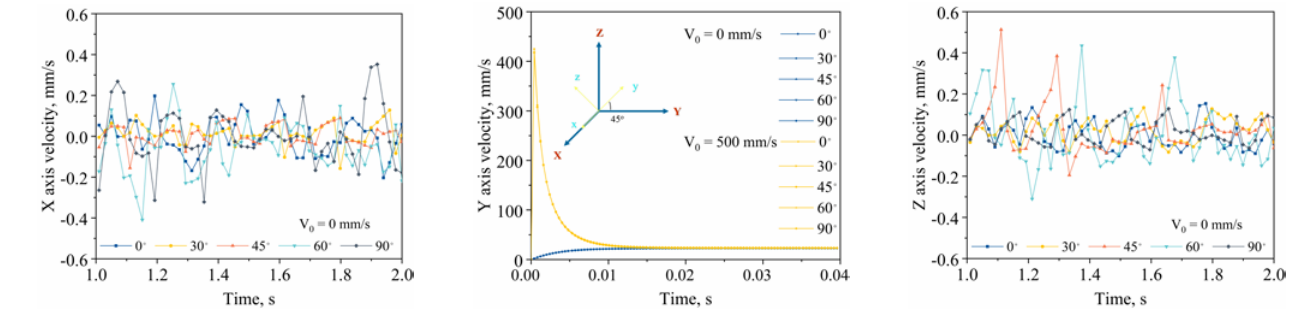
Figure 6. Three-dimensional velocity variation diagram of particles at different release angles.